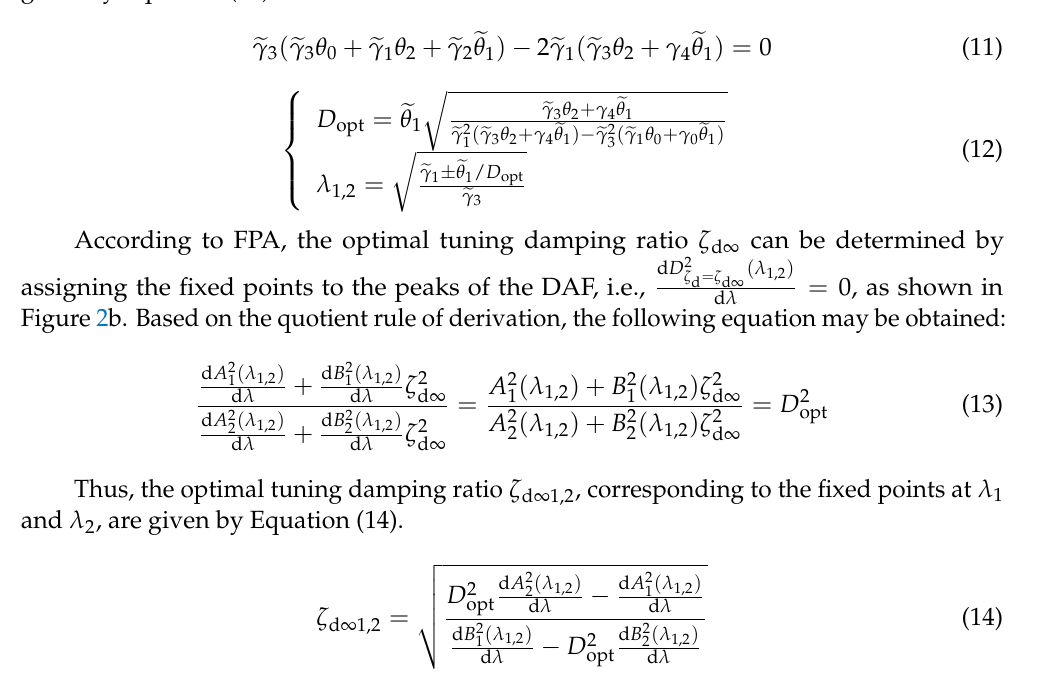
Considering the two fixed points, the optimal tuning damping ratio ζ d ∞ is taken (cid:113) + ζ 2 ζ 2 d ∞ 1 d ∞ 2 as ζ d ∞ = . Substituting Equations (9) and (12) into Equation (14), ζ d ∞ is 2 analytically obtained, as shown in Equation (15).